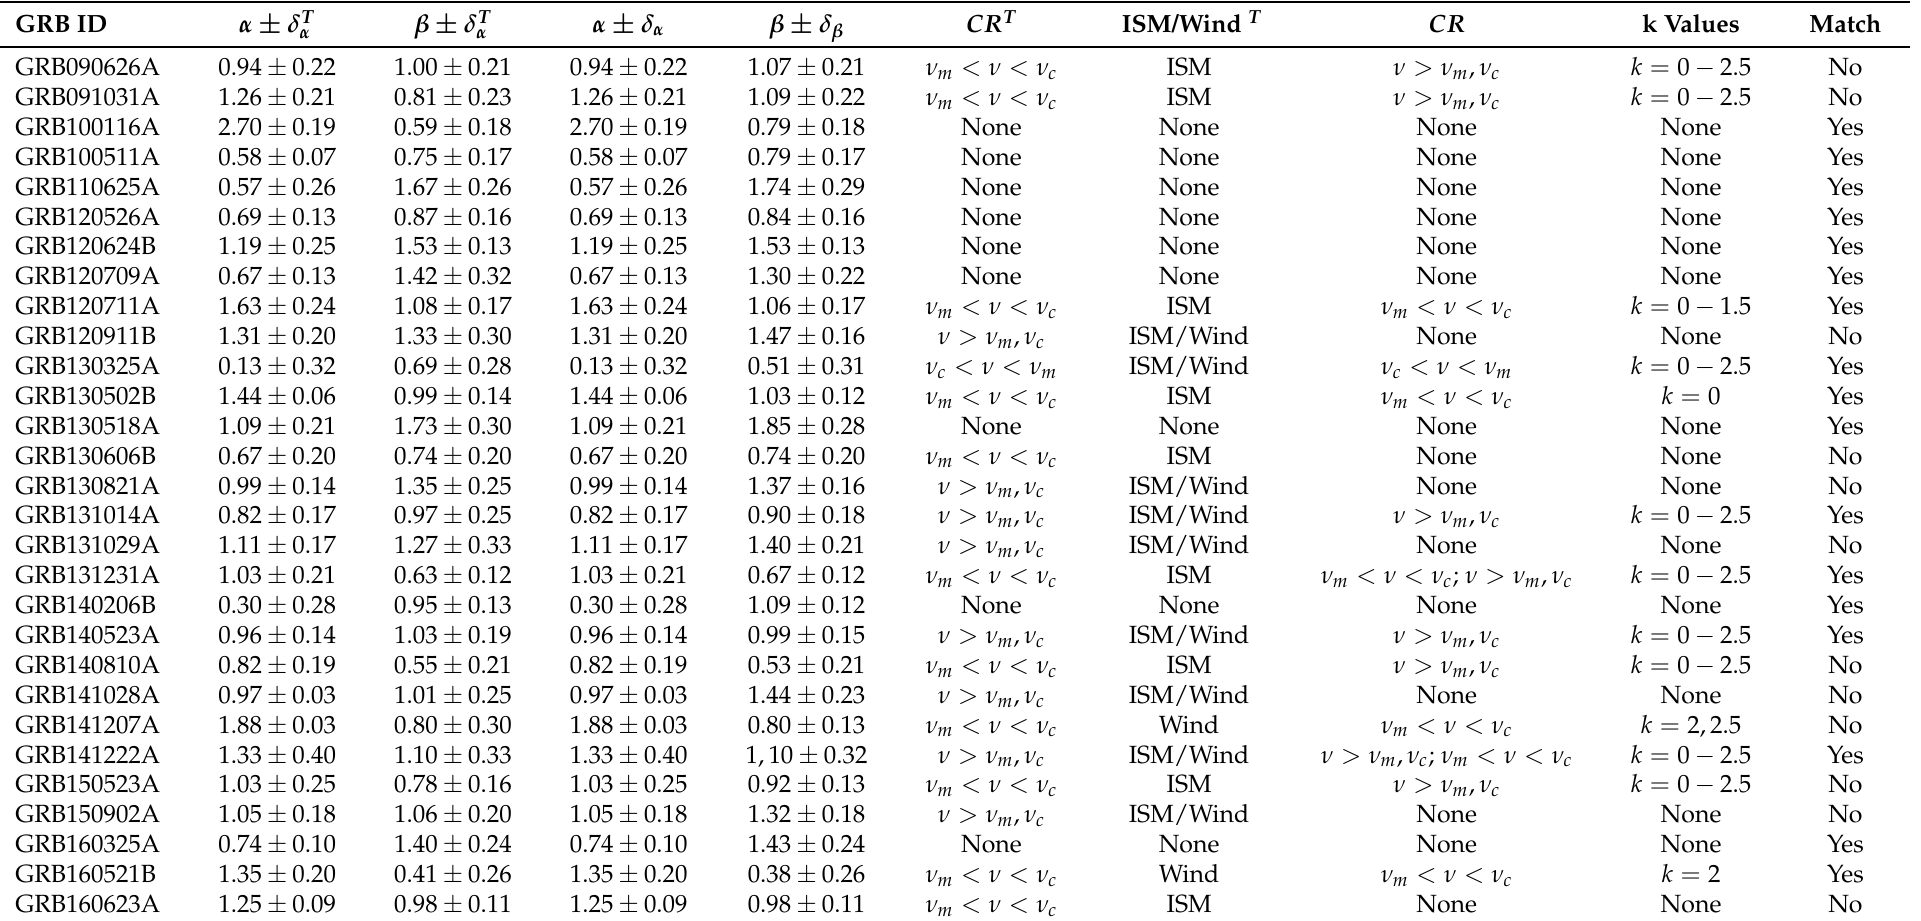
Table 4. Comparison between the CR satisfaction of 38 common GRBs between our sample and the analysis done in Tak et al. [50]. The first column is the GRB ID, the second and forth columns are the α for our analysis and Tak et al. [50], respectively. The third and fifth columns show the β indices for our analysis and Tak et al. [50]. The sixth and seventh columns show the fulfilled CR in Tak et al. [50] and its corresponding environment, whereas the eighth and ninth columns show the fulfilled CR and its corresponding environment in our study. The last column marks agreement with Tak et al. [50]. Data from Tak et al. [50] are marked with T